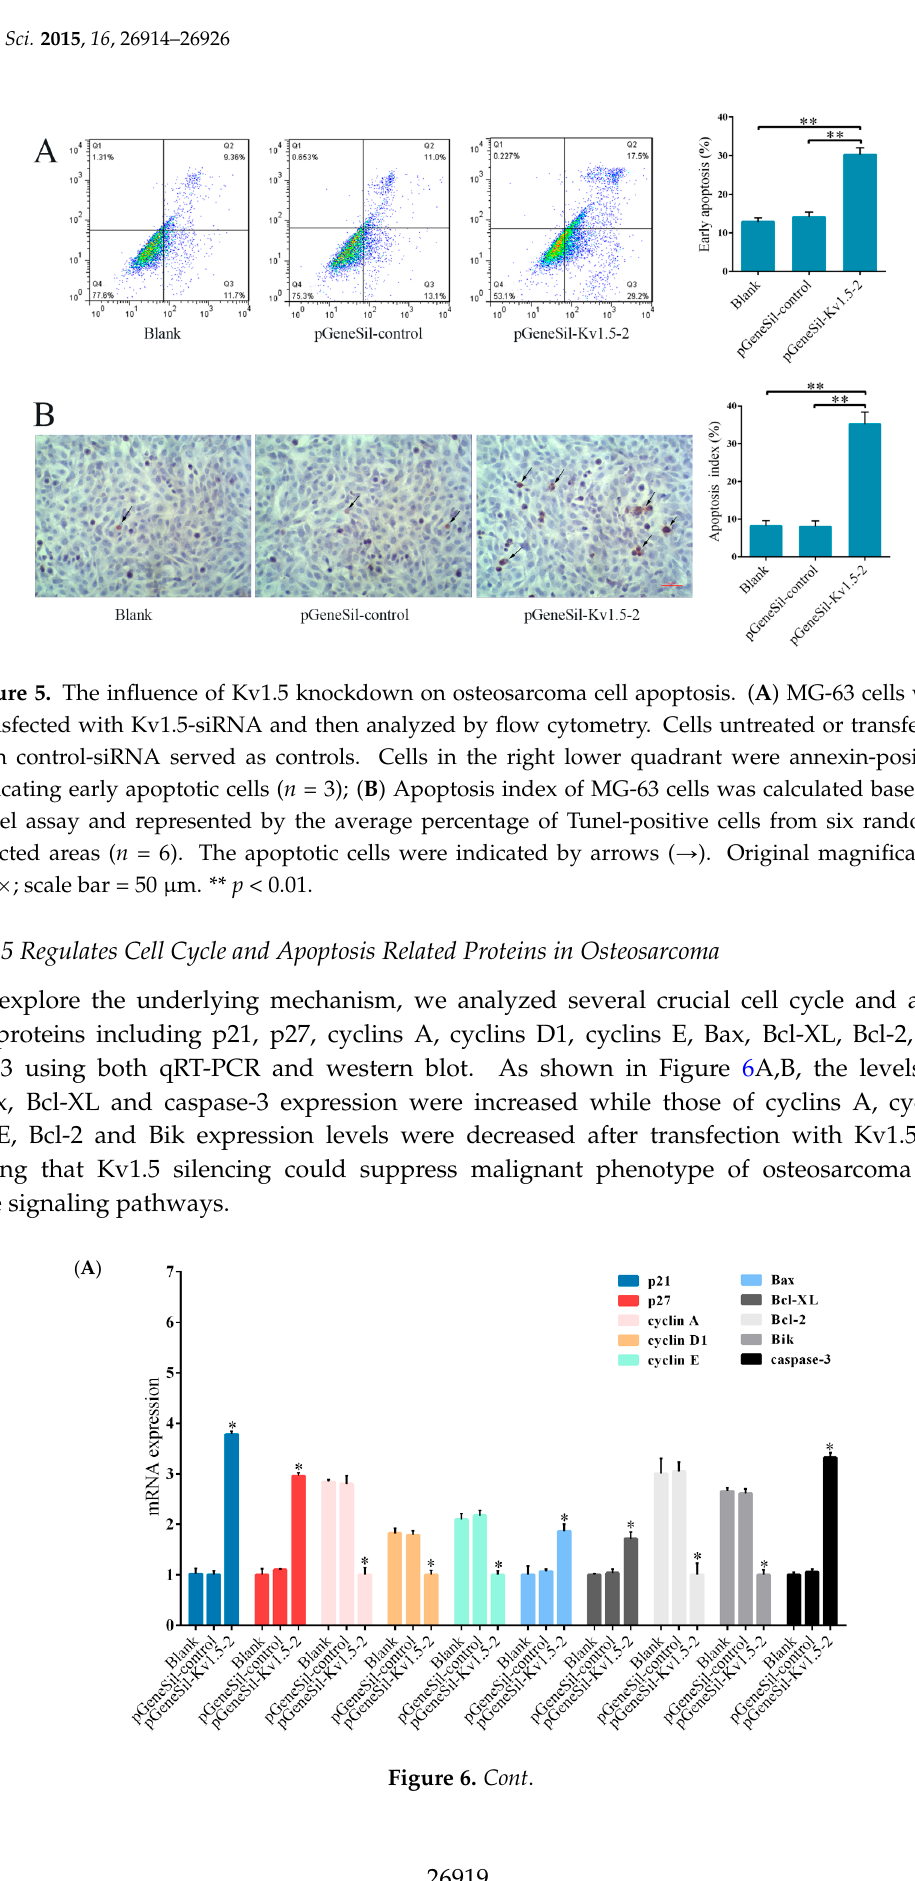
Figure 4. The effects of Kv1.5 knockdown on the progression of cell cycle. Cells were transfected with control-shRNA, or Kv1.5-shRNA, or left untreated for 48 h. Kv1.5 silence induced a significant increase in cells arrested in the G0/G1 phase and a decrease in cells arrested in the S phase. Representative images of each group were shown. *** p < 0.001. 2.5. Effects of Kv1.5 Silencing on the Apoptosis of Osteosarcoma Cells We next explored the effects of Kv1.5 silencing on apoptosis of osteosarcoma cells. We